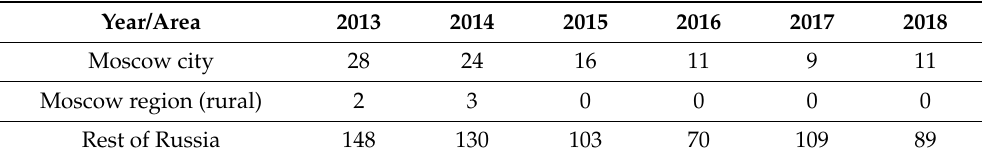
Table 4. Comparative incidence of human dirofilariasis in Moscow city and the Moscow region,